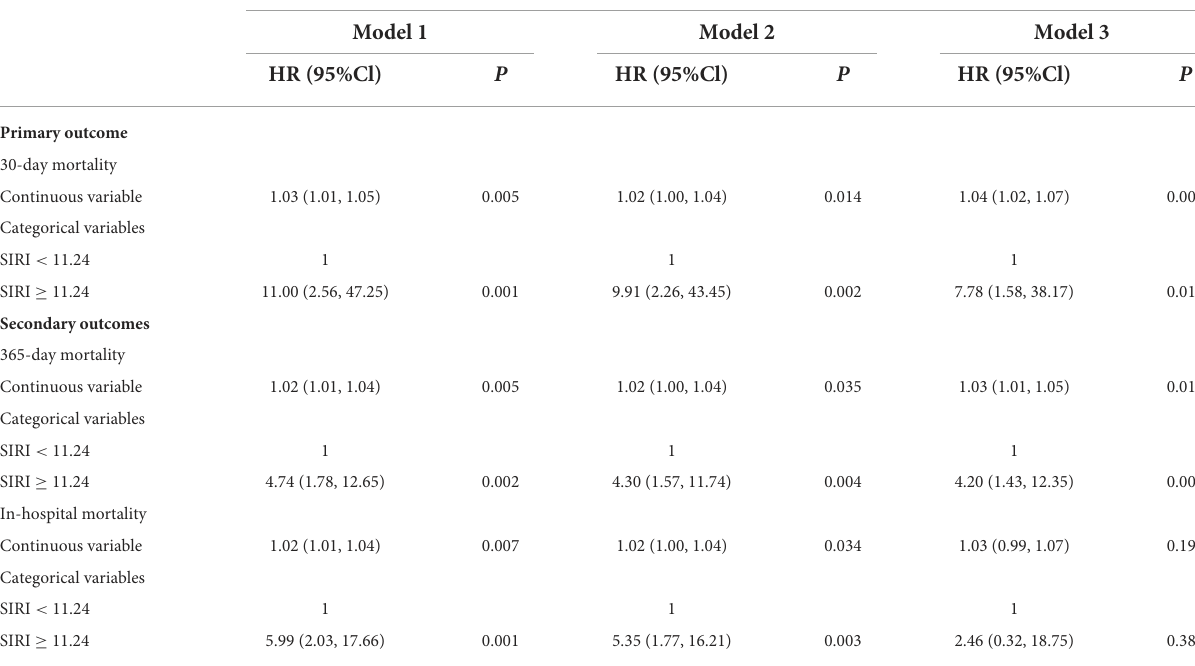
TABLE 3 Association between SIRI and clinical outcomes of critically ill patients with TBI after